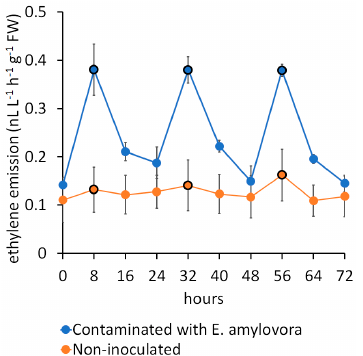
Figure 1. Ethylene release from in vitro kiwifruit plants contaminated with the incompatible pathogen Erwinia amylovora . The samples were enclosed in 150 mL pots. The GC analysis started 24 h after inoculation and was repeated every 8 h under a 16 h light/8 h dark photoperiod. The samples were vented after each reading. Data points circled in black correspond to ethylene accumulation during the dark phase.